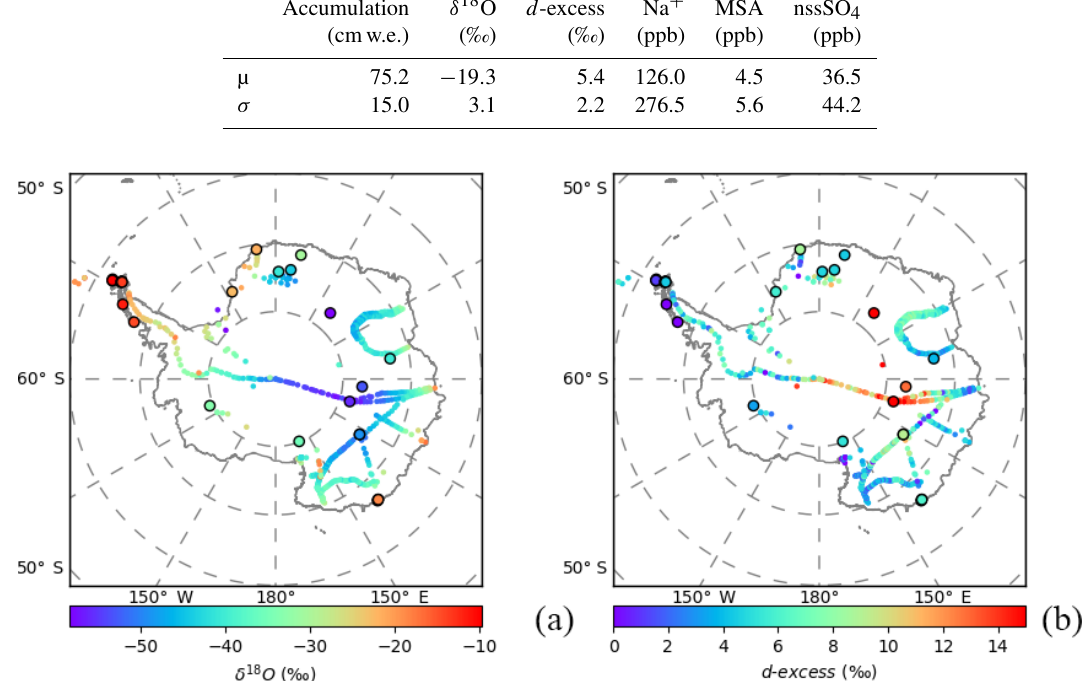
Figure 5. Spatial distribution of δ 18 O ( a , ‰) and d -excess ( b , ‰) in surface Antarctic snow based on our updated database combining data from precipitation, surface snow, pits, and shallow ice cores. Bigger points with a black edge correspond to new data compared to Masson-Delmotte et al.